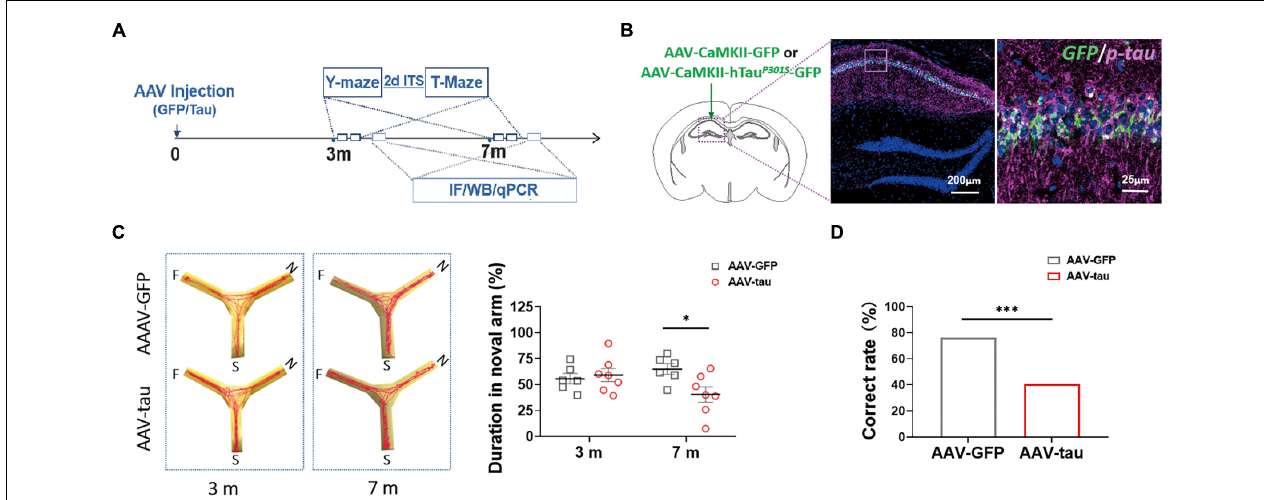
FIGURE 2 | Overexpression of p-tau induced cognitive dysfunction in mice with adeno-associated virus (AAV)-tau injection. (A) Experimental paradigm. (B) Representative images of the ipsilateral hippocampus taken from mice injected with AAV2/9-CaMKII-hTau P 301 S -GFP (called AAV-tau) into the hippocampus. The positive staining for phosphorylated tau at ser404 (purple) indicated successful animal model with p-tau overexpression. (C) Representative moving tracks (left) and the percentages of time spent in the novel arm (right) of mice that received AAV-tau ( n = 8) or AAV-GFP ( n = 6) injections in Y-maze at 3 and 7 months time points. (D) Working memory of mice was assessed by the total correct rate of six trials at 3 ( n = 10) and 7 months ( n = 7 and 12, AAV-GFP and AAV-tau) post-injection in a T-maze test. Two-way ANOVA was performed followed by Bonferroni’s multiple comparisons test. Pearson chi-square test was also performed, ∗ p < 0.05, ∗∗∗ p <